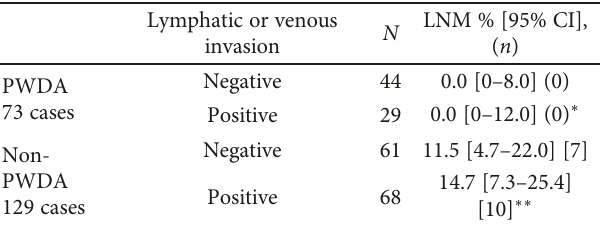
Table 5: The relationship of LNM between PWDA and lymphatic or venous invasion in T1